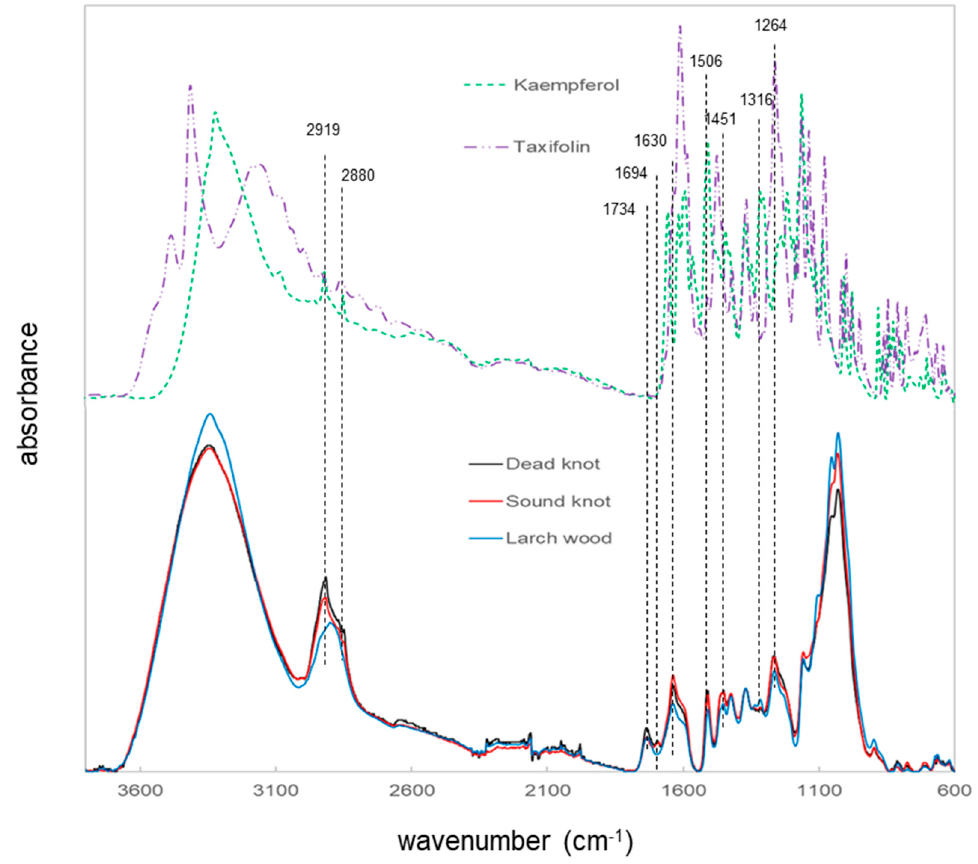
Figure 4. ATR FT-IR spectra of larch wood, sound and dead knotwood as well as kaempferol and taxifolin.